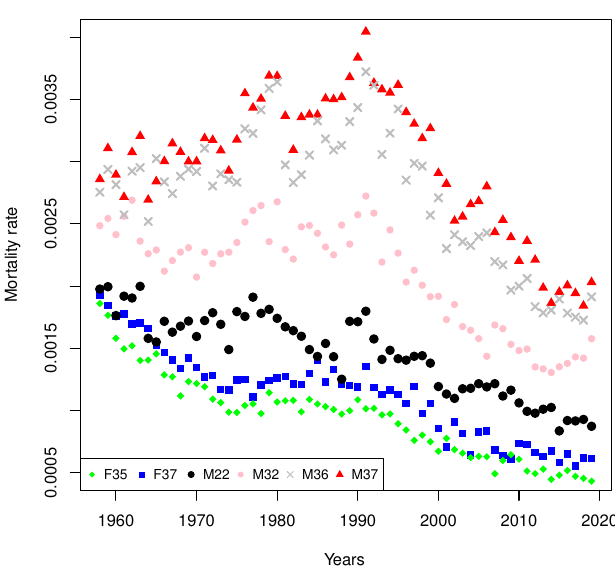
Figure 1. The values of the empirical mortality rates: F 35 , F 37 , M 22 , M 32 , M 36 , M 37 .